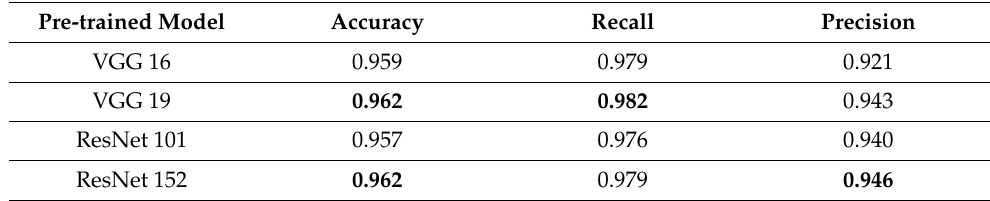
Table 6. Performance using k -means